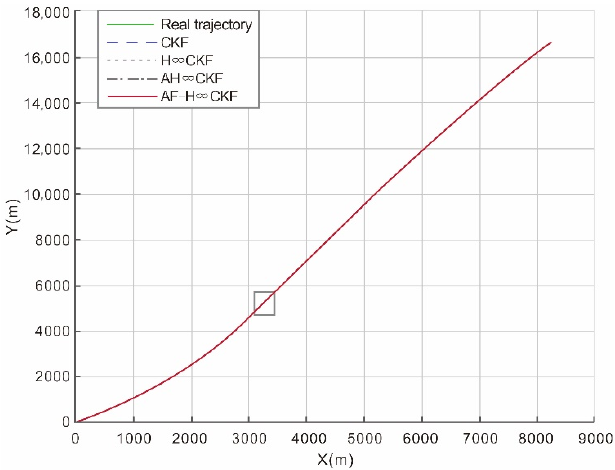
Figure 4. Trajectory in Case 1.